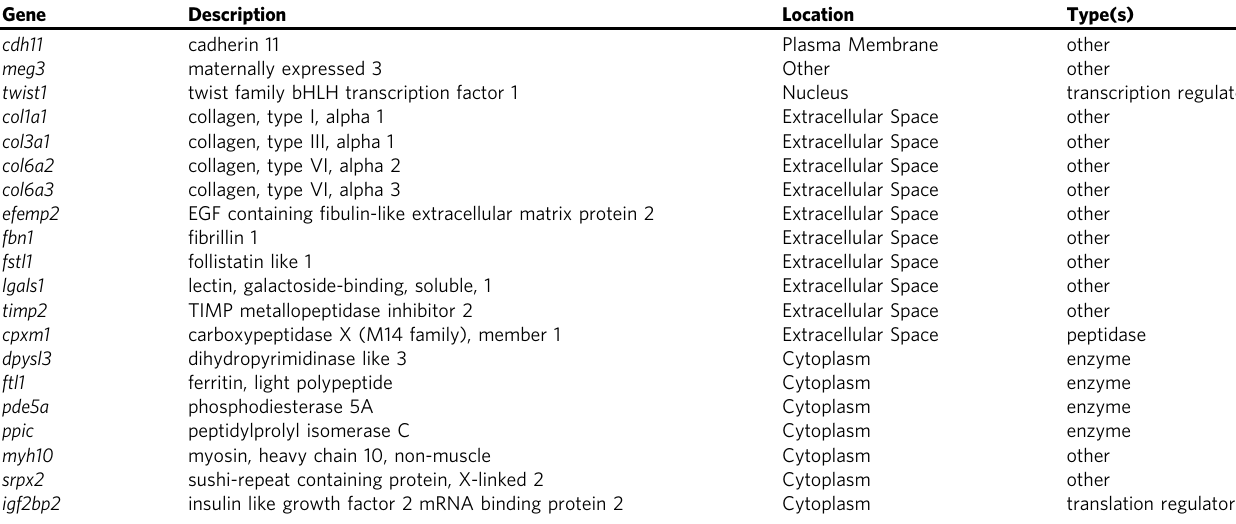
Table 2 The 20 signi fi cantly upregulated genes related to hair placode formation at epidermis wound center compared to wound margin on